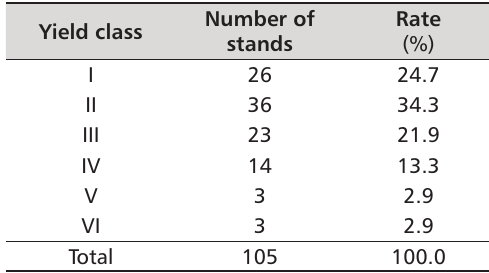
TABle 2. Distribution of the measured stands by yield class